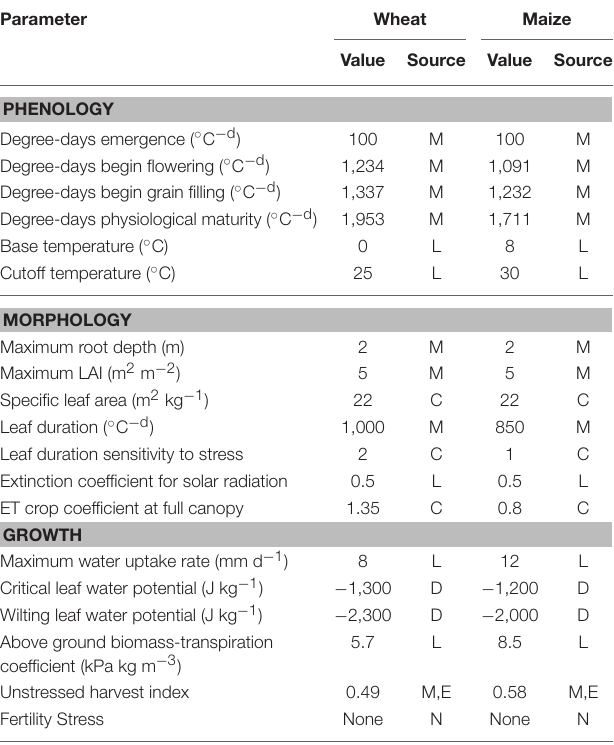
between a depth of 0 and 180 cm. Depth of the water table TABLE 4 | Parameters used in the CropSyst model to simulate winter wheat and summer maize cropping. was measured with a water level logger (Hobo U20-001-01, Onset Corp., Bourne, MA). Vapor pressure deficit was calculated Parameter Wheat Maize from temperature and relative humidity data that was measured Value Source Value Source with a temperature-relative humidity data logger at 0.1, 3, and 10 m. Soil temperatures at 0.05 m were measured with a digital thermometer. ET was measured by an EC system composed of a CSAT3 sonic-anemometer and a LI7500 H 2 O/CO 2 gas